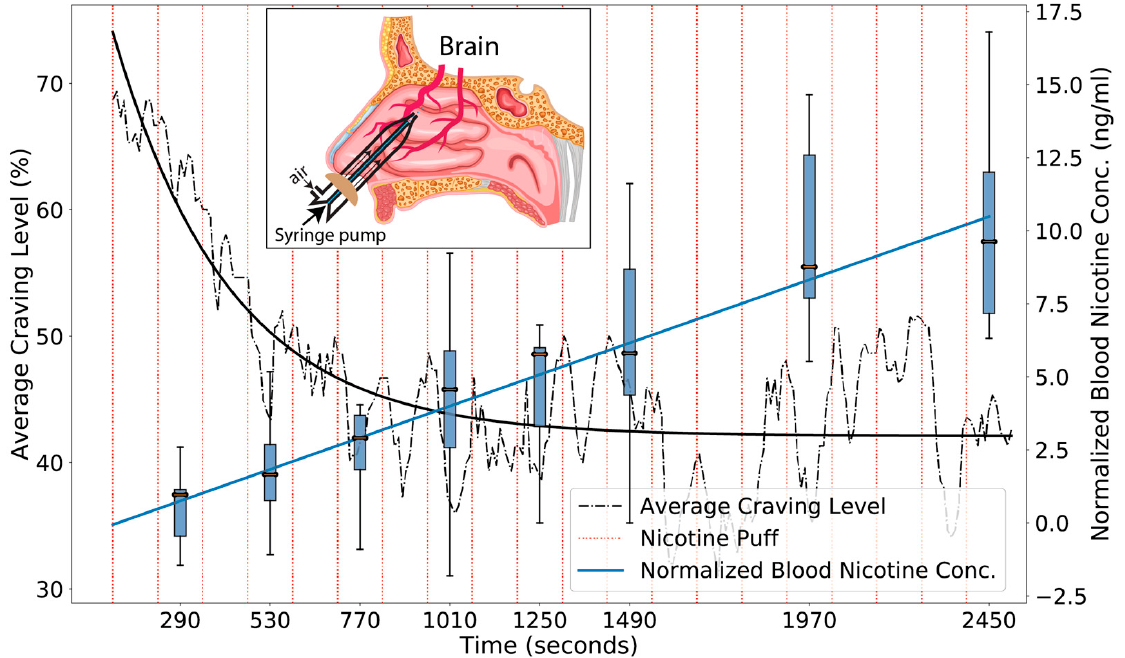
Figure 2. Nasal nicotine administration every 2 min linearly increases nicotine concentration and exponentially decreases subjective cravings. On average each spray of 10 µ L delivers 0.6 ng/mL into the blood stream, with a delivery efficiency of 3.4% ( Studies A, B ).